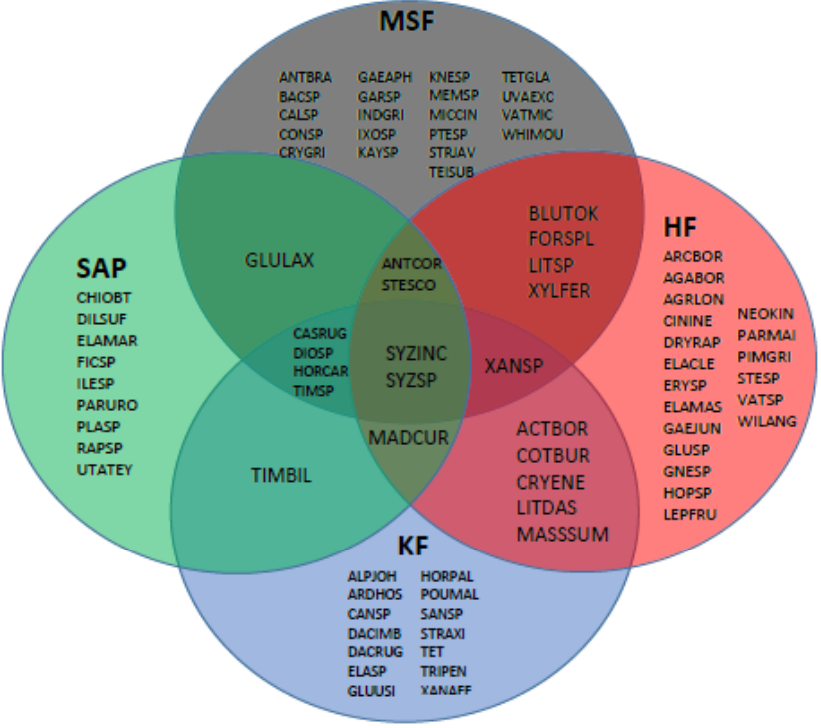
Figure A1. Venn-diagram to illustrate the distribution of woody seedling species recorded across the four forest types: mixed peat-swamp forest (MSF, n = 4 plots), heath forest (HF, n = 6 plots), kerapah (KF, n = 6 plots) and Shorea albida peat-swamp forest (SAP, n = 6 plots). Species codes and their definitions are listed in Table A1.